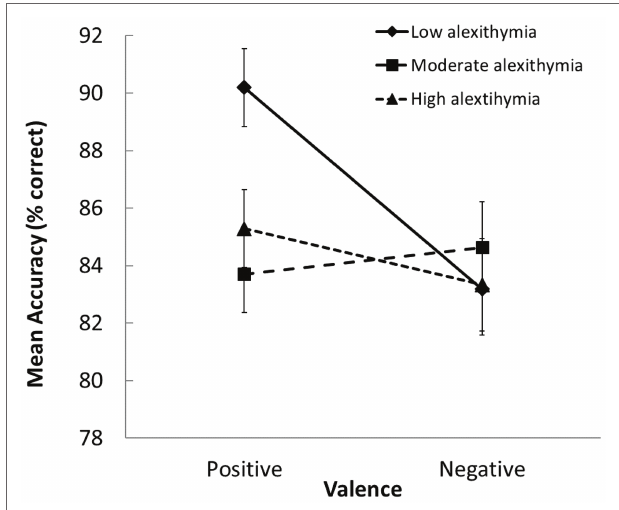
FIGURE 2 | Group differences in how accurately positively and negatively valenced scenes were evaluated (SEs indicated). Participants with moderate- to-high alexithymic traits were less accurate at judging the valence of positive scenes than those with low alexithymic traits.